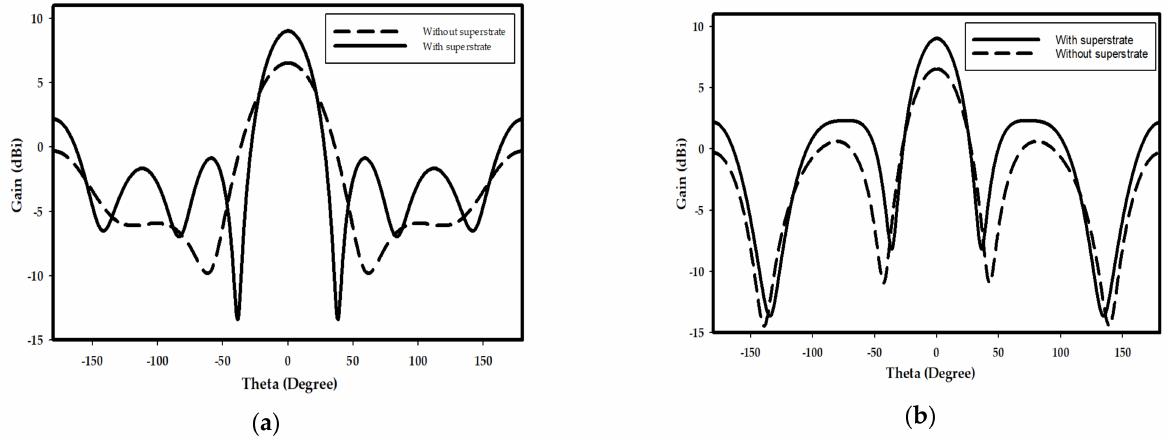
Figure 11. Radiation pattern of DRA with and without superstrate at ( a ) ϕ = 0 ◦ ; ( b ) ϕ = 90 ◦ .